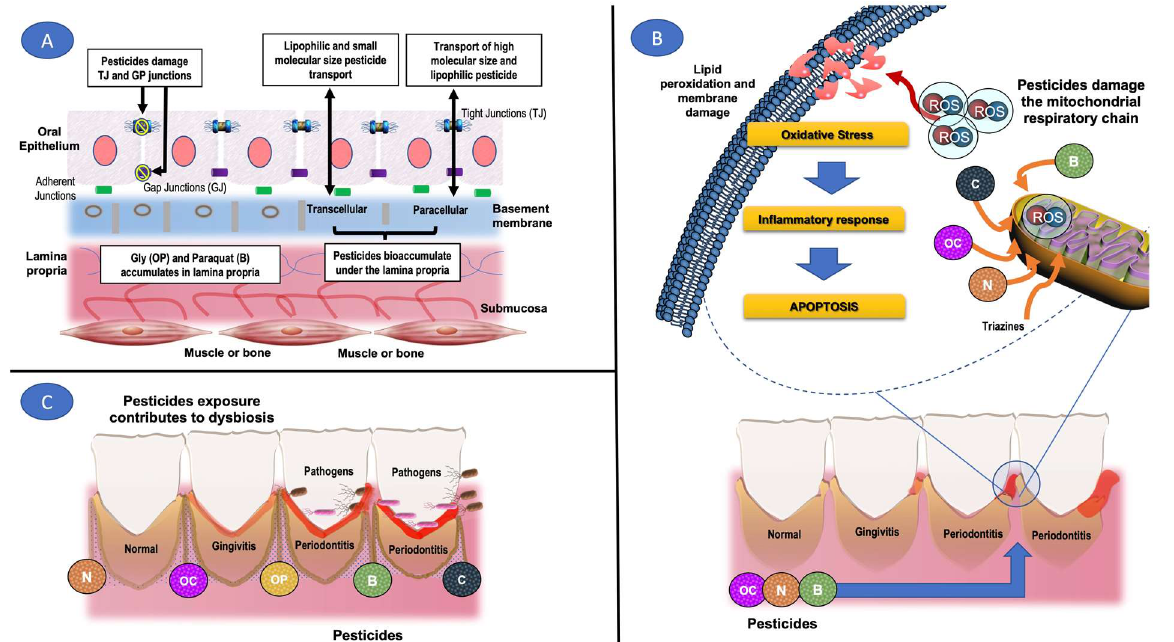
Figure 2. Pesticides and their interaction with tissues of the oral cavity. ( A ) Pesticide transport in oral epithelium. ( B ) Contact of pesticides with the gum tissue participates in the development of periodontitis. ( C ) Mechanism of tissue damage due to exposure to pesticides. Some pieces of the image were modified of QIAGEN’s original, copyrighted pictures by Torres-Sanchez ED. The original image may be found at https://geneglobe.qiagen.com/es/explore/pathway-details/mif-mediated-glucocorticoid-regulation?pwid=29 (accessed on 12 August 2018) in conjunction with any use of the IMAGES, either on the IMAGES themselves or in close proximity to the IMAGES, such that QIAGEN’s right in the original IMAGES shall be conspicuous.